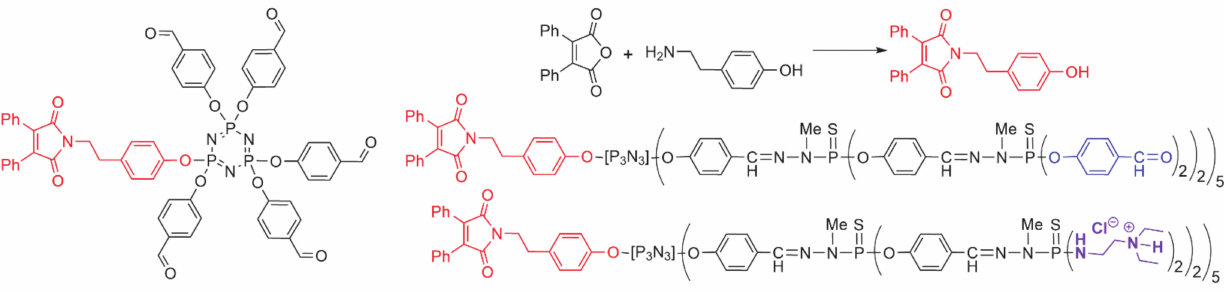
Figure 5. Dendrons functionalized with a single fluorescent maleimide at the core and with either 20 aldehyde or 20 ammo- nium terminal